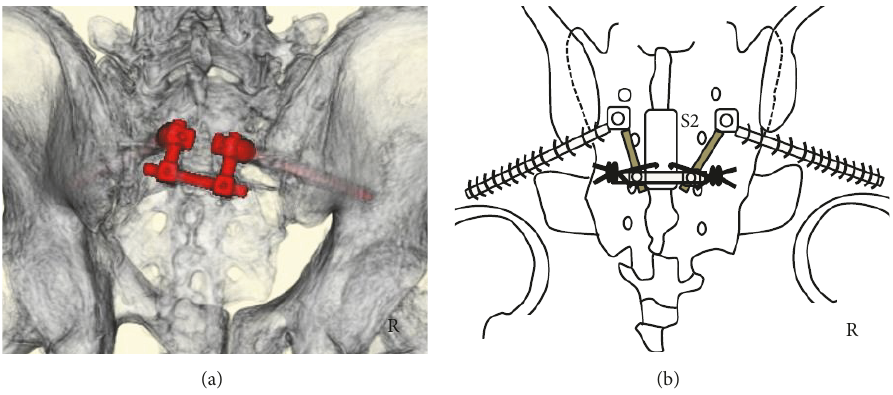
Figure 3: Postoperative three-dimensional computed tomography (CT) and schemata . (a) Three-dimensional CT. (b) Operation schema. Three- dimensional CT showing S2-3 laminectomy and S2AI screws and rods (red color) (a). Surgical method (b): we performed S2-3 laminectomy and then passed ultrahigh molecular weight polyethylene (UHMWPE) cables from the central laminectomy area to the third posterior sacral foramina. We inserted S2AI screws and connected the rods, after which the UHMWPE cables were tightened to the rods.